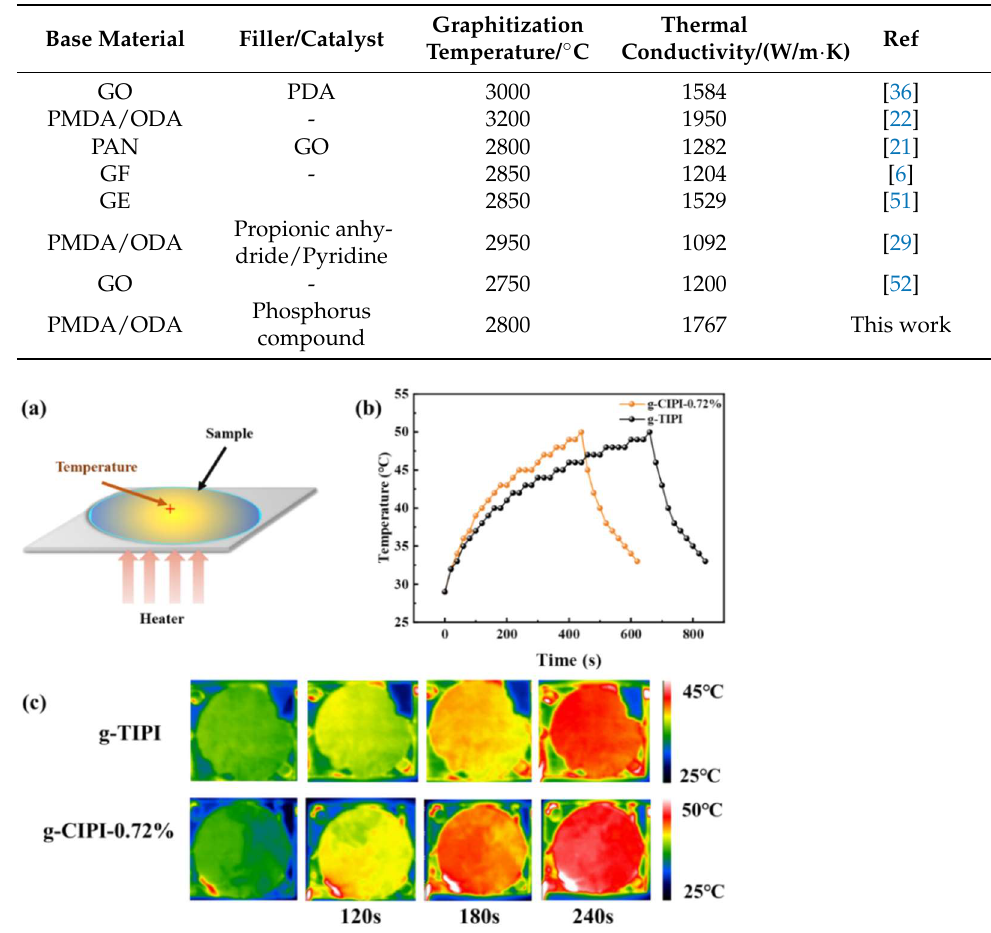
Figure 8. ( a ) The schematic diagram for heat source test equipment; ( b ) the relationship curves of temperatures of g-TIPI and g-CIPI-0.72% films with time; ( c ) infrared thermal images of g-TIPI and g-CIPI-0.72% films.